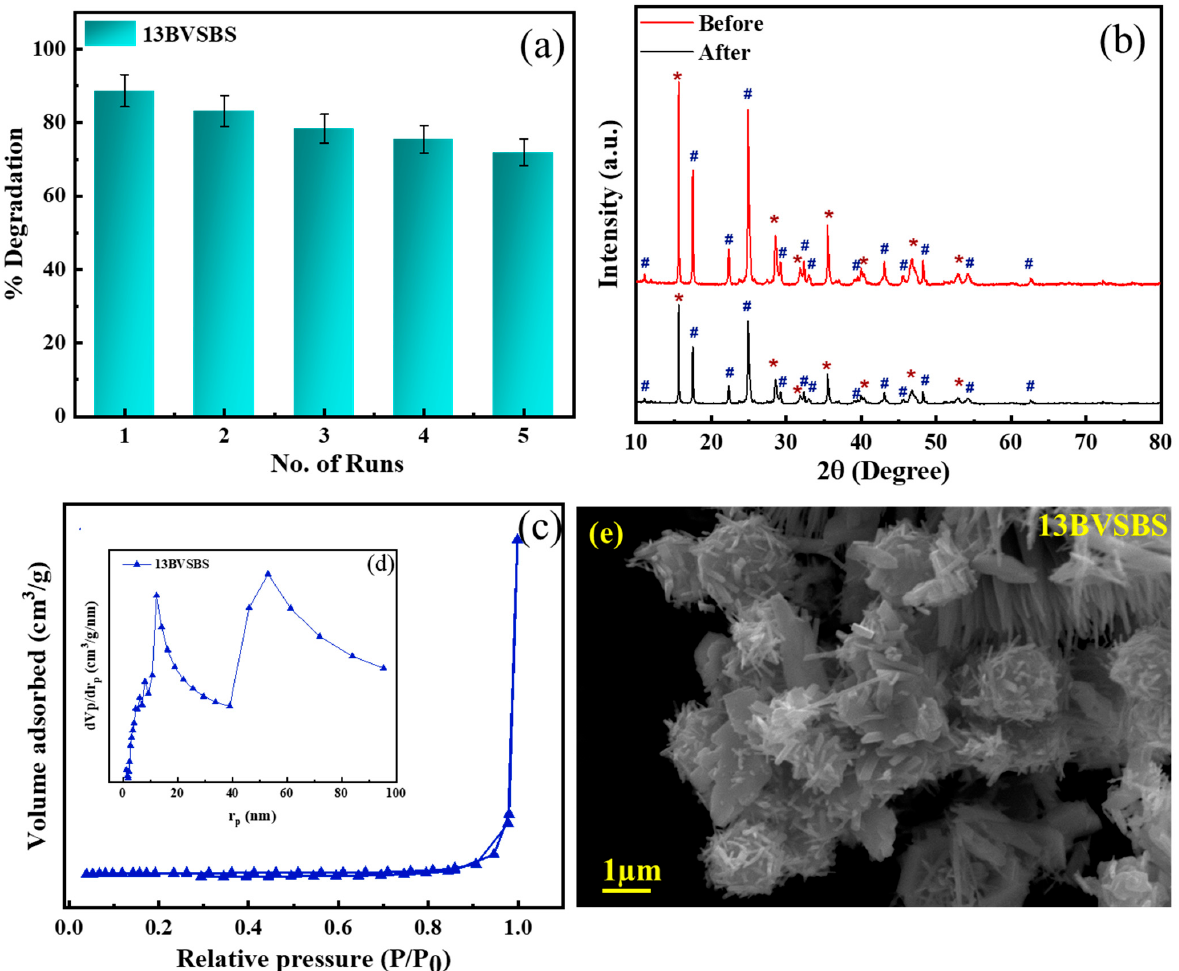
Figure 7. ( a ) The reusability graph, ( b ) XRD of 13BVSBS composite where * and # denote peaks of BV, and SBS, respectively, ( c , d ) BET with inset showing BJH graph, and ( e ) SEM image of the used catalyst’s post degradation studies.